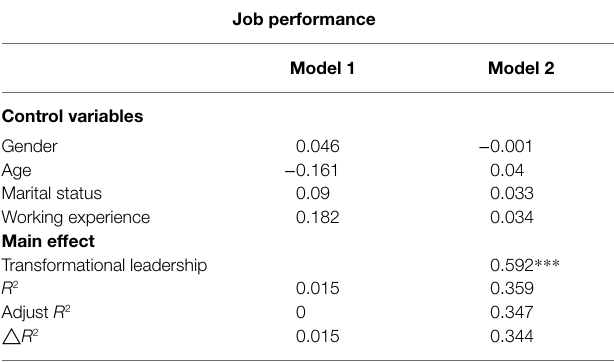
TABLE 4 | Regression analysis of transformational leadership and job